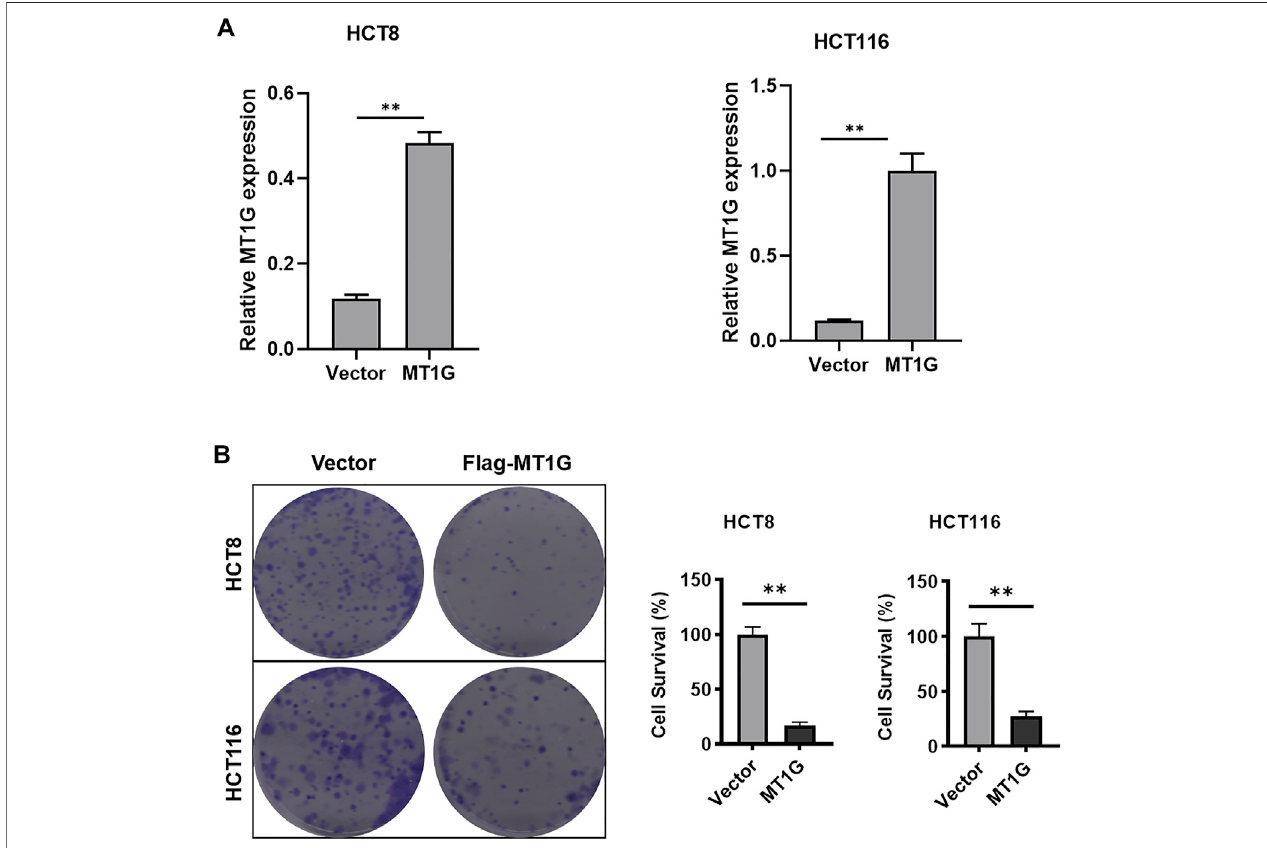
FIGURE 4 | Overexpression of MT1G inhibited CRC cell growth. (A) Overexpression of MT1G in HCT8 and HCT116 cells. (B) Colony formation rate of HCT8 and HCT116 cells after the MT1G overexpression. * p < 0.05; ** p < 0.01; and *** p < 0.001.